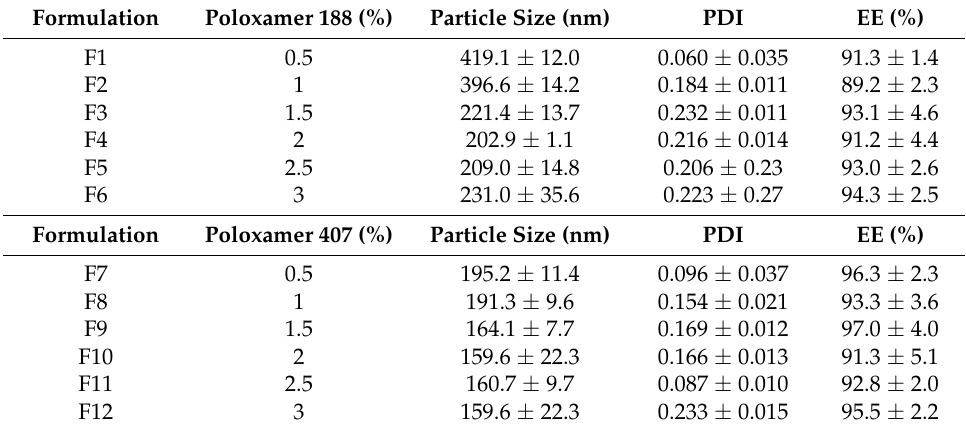
Table 1. Formulations and the particle size, PDI and EE of H-SLNs dispersion; Data are expressed as the mean ± S.D. ( n = 3). The volume of surfactant solution and H. cordata extracts is 20 mL and 0.2 mL,